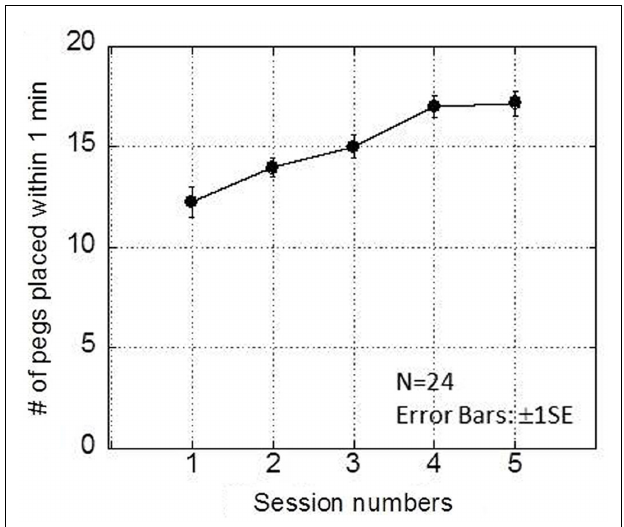
FIGURE 3 | Results obtained in the intrinsic delay condition of experiment 1. This graph plots the number of pegs placed within 1min as a function of session number. A rapid buildup of performance was observed within five sessions.